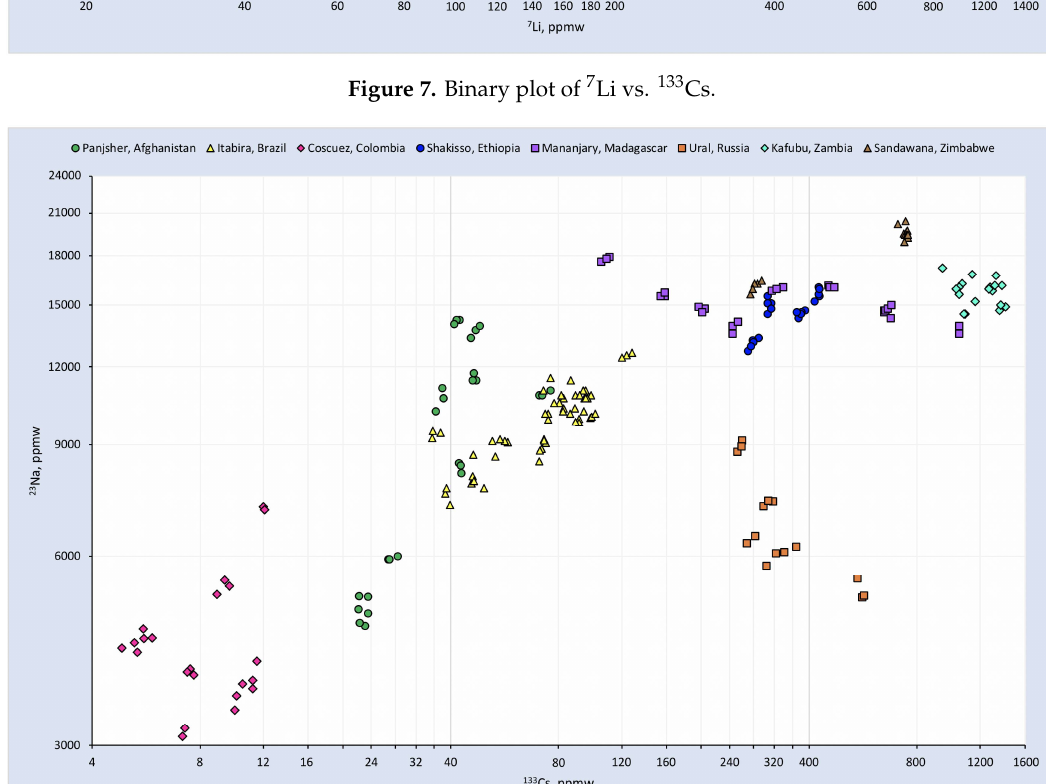
Figure 8. Binary plot of 133 Cs vs. 23